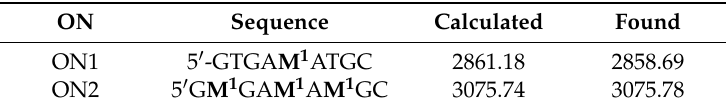
Table 3. Sequence and MALDI-MS of modified oligonucleotides ON1 and ON2 . ON Sequence Calculated